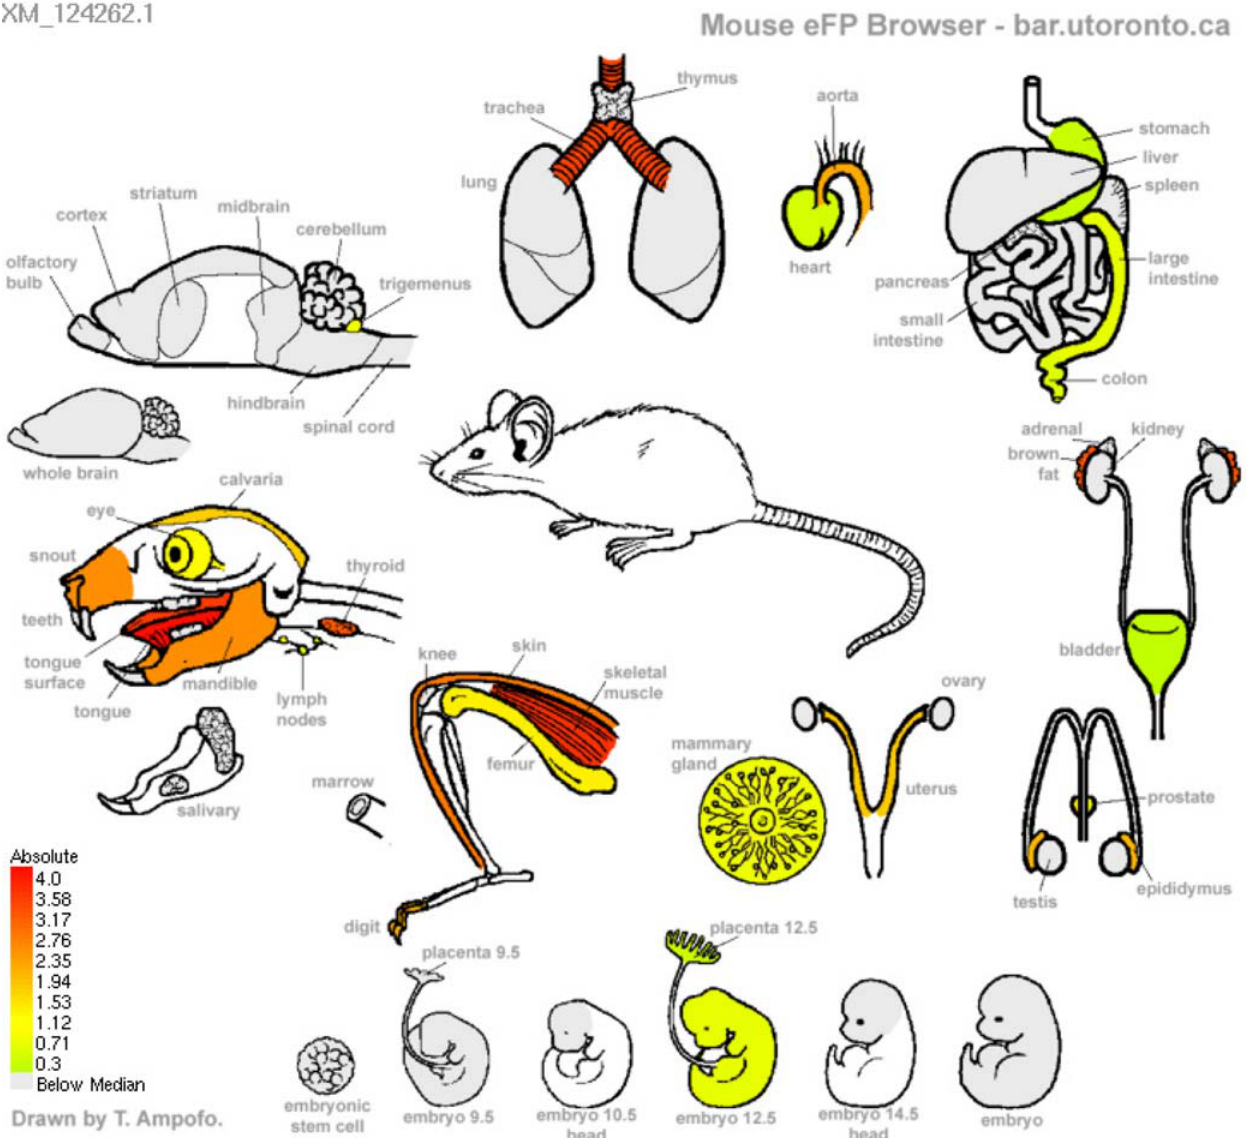
Figure 9. An exemplary Mouse eFP Browser output image. The expression level for myosin (XM_126201.1) is strongest in skeletal muscle and a couple of other areas, such as the trachea, as denoted by the strong red colouration